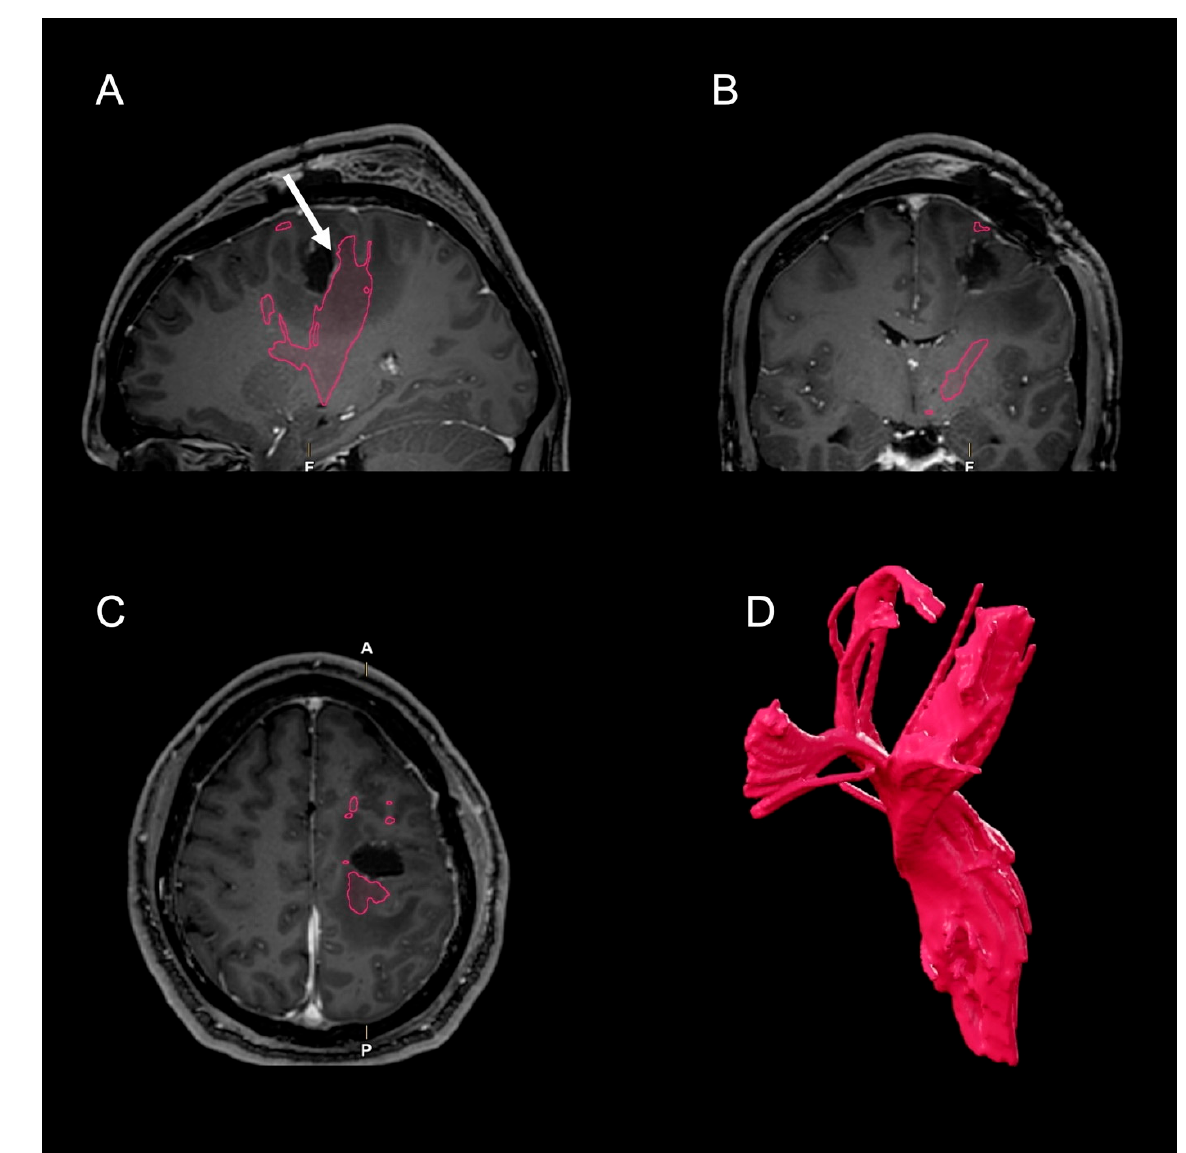
Figure 2. Postoperative MRI in T1-weighted sequence with contrast enhancement ( A – C ). Arrow: location of positive intraoperative DES at 2 mA. The contrast-enhancing parts of the tumor were completely resected. Edema was already reduced. Red outlines: CST. ( D ) Postoperative tractogram of the left CST (red) still shows some fibers ventral to the situs. However, the dorsal parts appear much stronger than preoperatively. (MRI: magnetic resonance imaging; CST: corticospinal tract; DES: direct electrical stimulation).